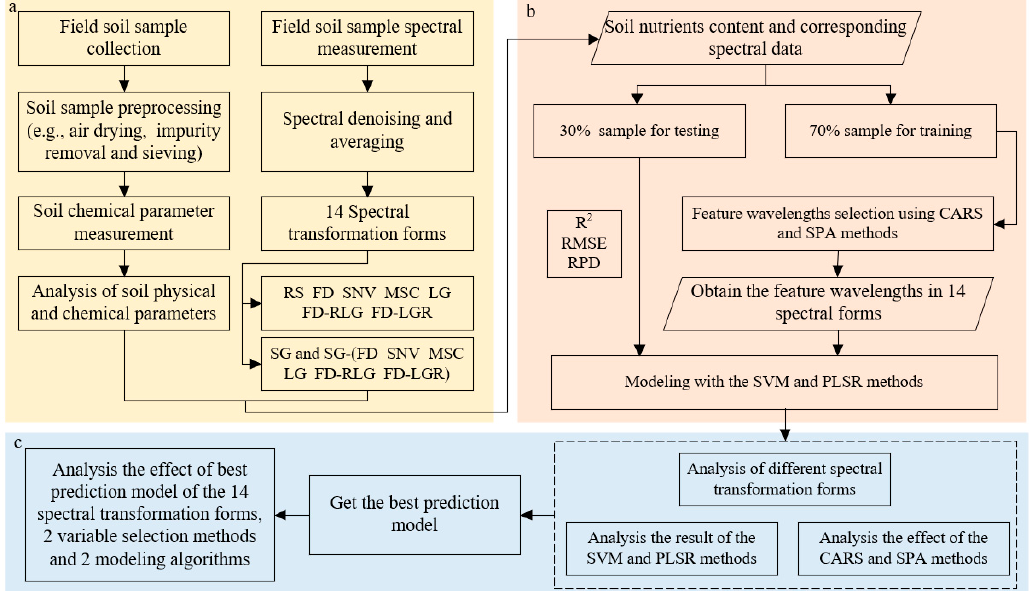
Figure 2. Method flow chart. ( a ) Data preprocessing; ( b ) variable selection and modeling; and ( c ) analysis of the results.